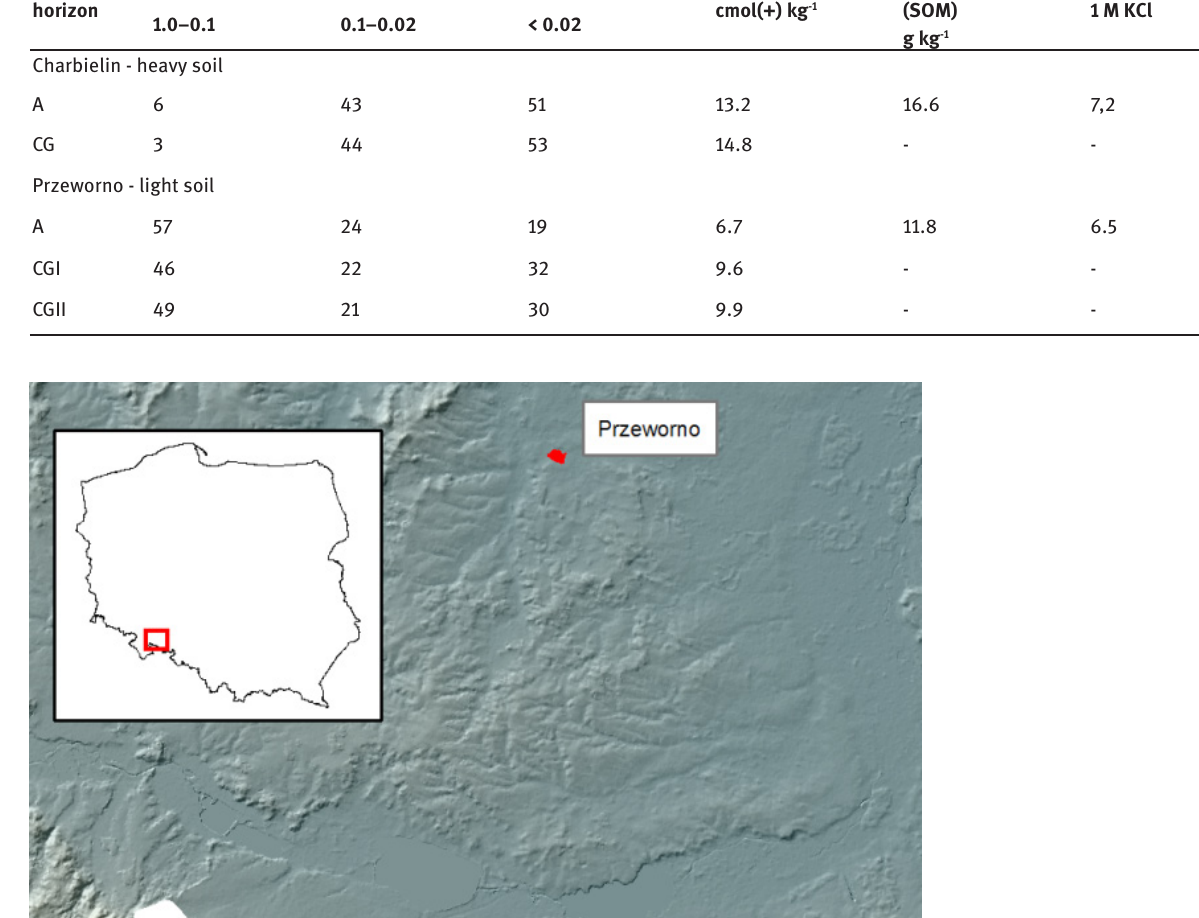
Table 1: Soil properties in the experimental areas. Genetic horizon